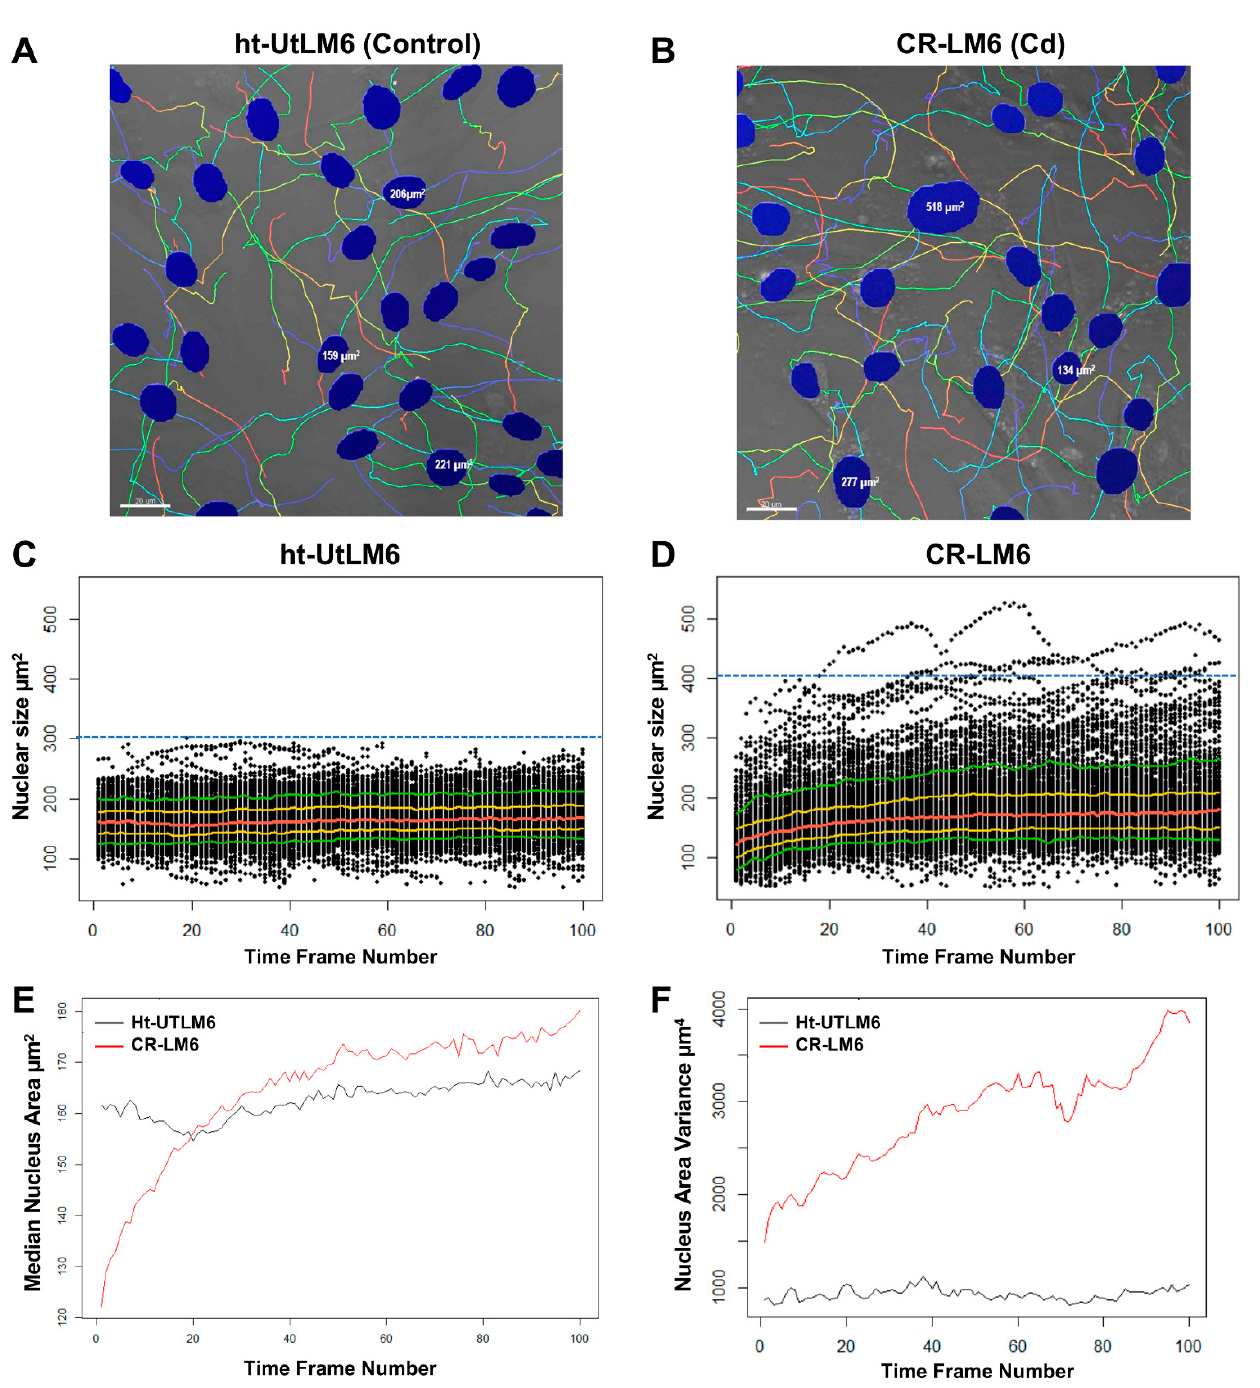
Figure 5. Cd exposure increased heterogeneity in nuclear size. The nuclear size, shape and migration tracks are shown. ( A ). ht-UTLM6. ( B ). CR-LM6. Scale bar = 20 µ m. ( C , D ). Scatterplots to show the distribution of nuclear size over time. Note the presence of large nuclei on top of the plots. The five colored curves correspond with median (red), 25% and 75% quantiles (gold) and 10% and 90% quantiles (green). ( C ). ht-UtLM6. ( D ). CR-LM6. As shown by the blue dashed line, in ht-UtLM6 there was no nuclear objects with a size greater than 300 µm 2 , whereas in CR-LM6 there were 190 nuclear objects with a size greater than 400 µm 2 . ( E ). Medians of nuclear size at each time point were plotted against frame number. ( F ). Variances of nuclear size at each time point were plotted against frame number.